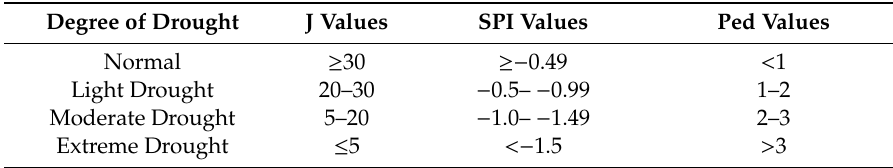
Table 2. Classification of drought according to the Drought Index (J), the Standardized Precipitation Index (SPI), and the Ped